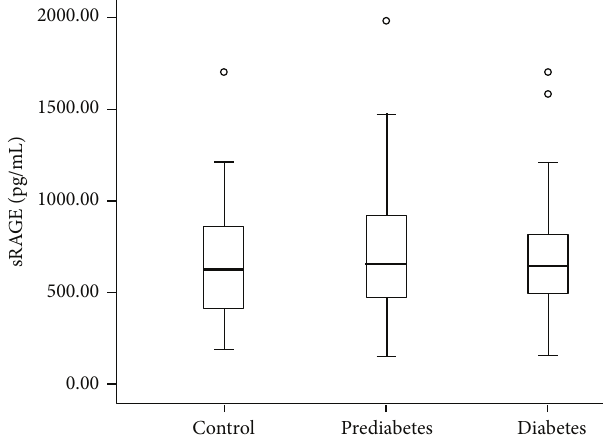
Figure 1: Box plot showing the sRAGE concentrations in control subjects and in people with prediabetes and newly diagnosed type 2 diabetes. The line within the boxes represents the median, the bottom of each box represents the 25th percentile, and the top of the box represents the 75th percentile. The whiskers represent the 5th and 95th percentiles, and the small circles represent